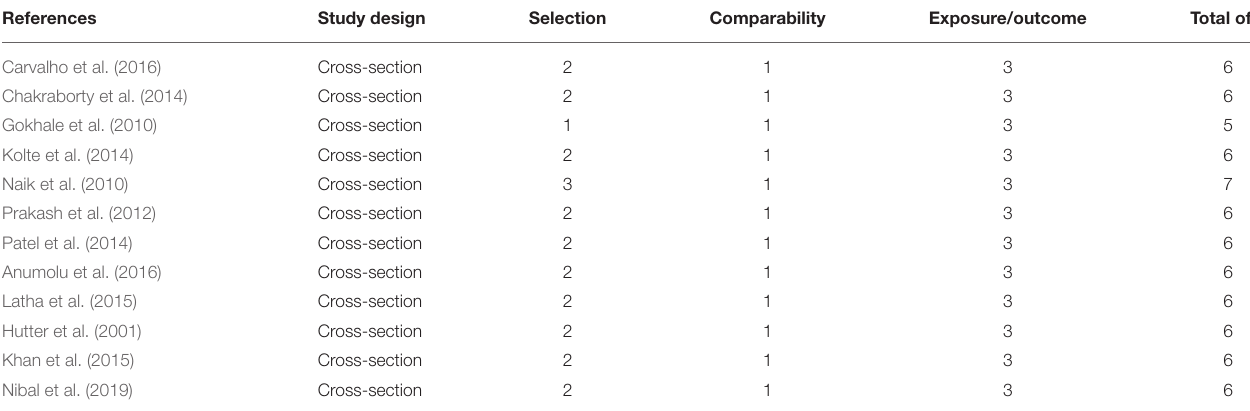
TABLE 3 | Quality assessment of the included study in this